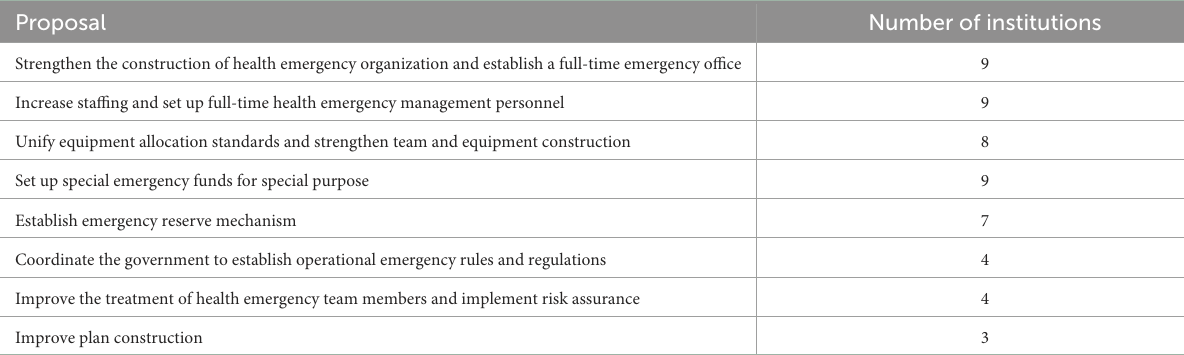
TABLE 2 Recommended demand for health emergency system construction of disease control institutions in M City.